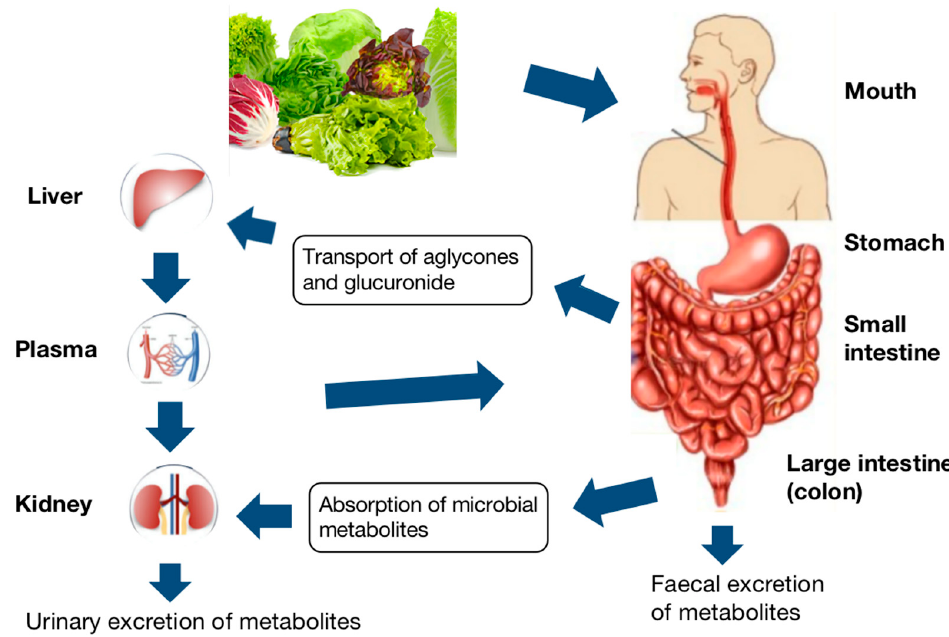
Figure 3. Schematic layout of the digestive pathway of phenolic compounds [81] .